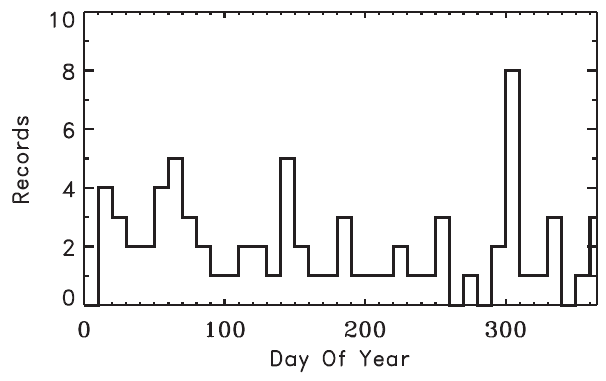
Fig. 9. Event distribution as a function of day of year. Records indicate number of events per 10 day